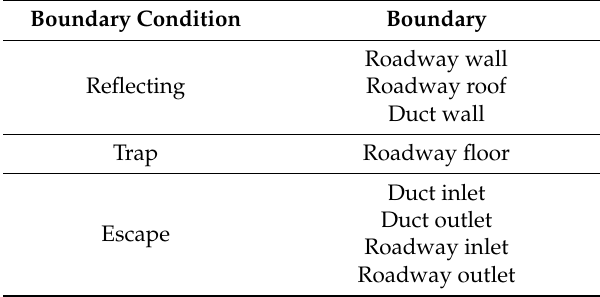
Table 5. Wall collision boundary